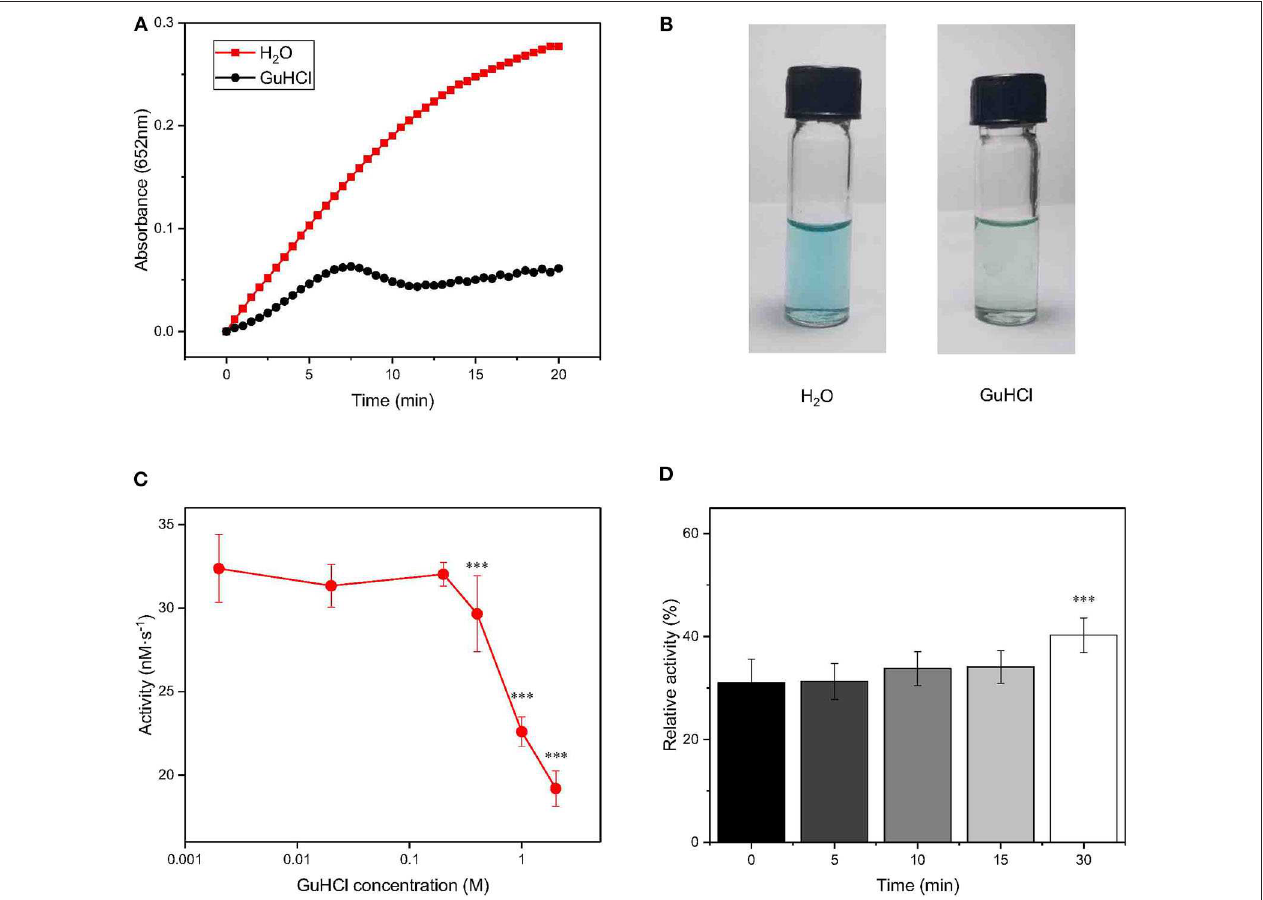
FIGURE 1 | Changes in the activity of IONzyme at different concentrations of GuHCl. IONzyme (final concentration, 0.5 µ g/100 µ l) was mixed with 2.0M GuHCl in water at room temperature. H 2 O 2 (0.6M) and TMB (0.4mM) suspended in 200mM sodium acetate buffer (pH 4.5) were added to the reaction mixture, followed by measurements of the absorbance at 652nm (pH 4.5, 37 ◦ C) (A) . Changes in the absorbance between 0 and 150s were used to calculate the peroxidase-like activity of IONzymes (nM · s − 1 ). Aliquots (blue, oxidized TMB) were taken in Eppendorf tubes from the reaction at 2min, compared with H 2 O as a control (B) . IONzyme was mixed with different concentrations of GuHCl, and aliquots were taken for activity measurement ( n = 12) (C) . The data on the relative changes in the peroxidase activity of IONzyme incubated with 2.0M GuHCl for different times were normalized to those of the untreated control ( n = 6) (D) . Data are the mean ± SD. *** P <